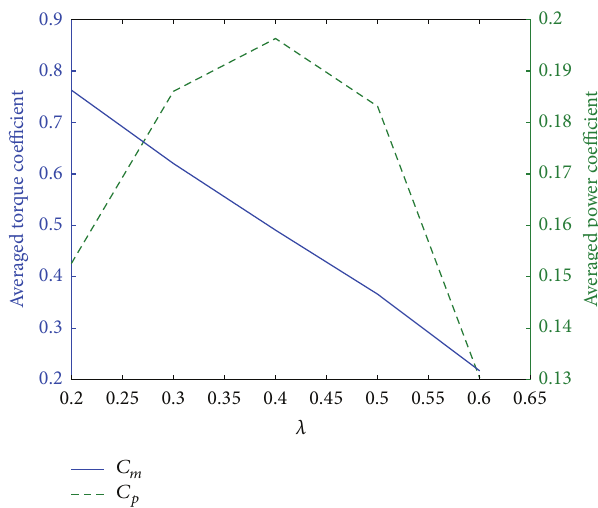
Figure 5: Coefficients of the averaged torque and power versus the flow coefficient.